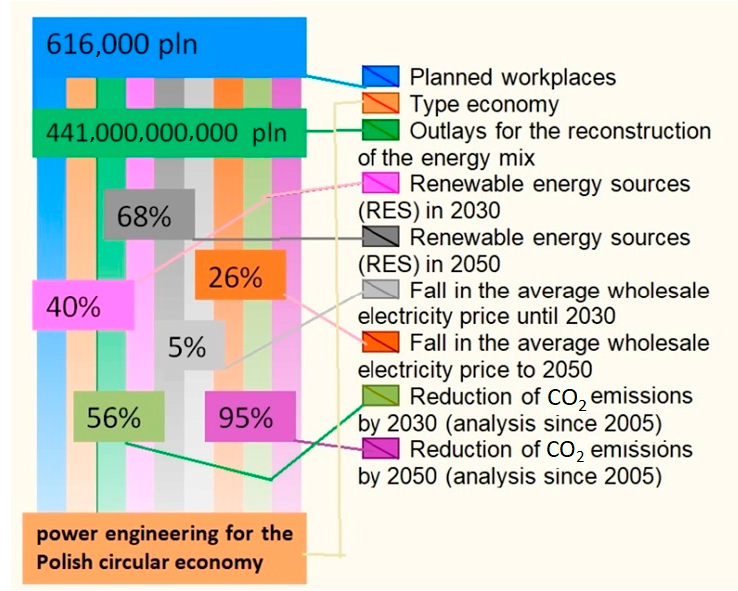
Figure 2. Dimensions and assumptions of the energy policy 2040 [9–11].